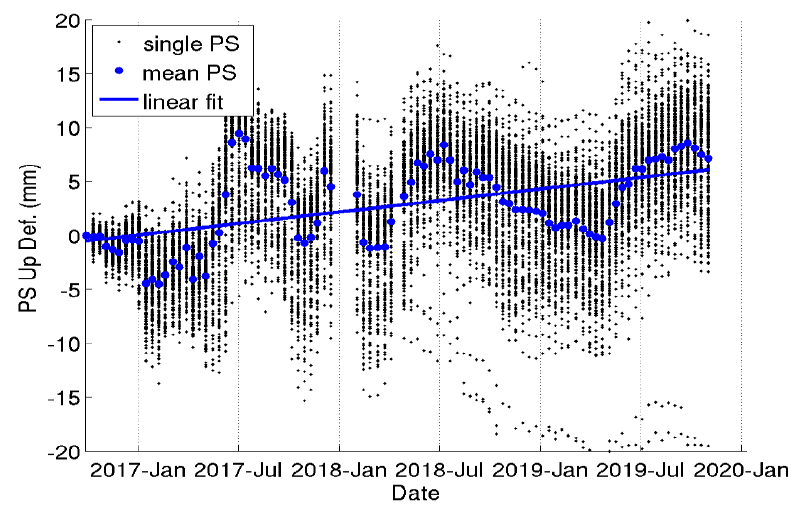
Figure 4. Permanent scatterers’ time series of the coastal area (bounded by a red dashed polygon in Figure 3), mean vertical deformation values and the linear trend.